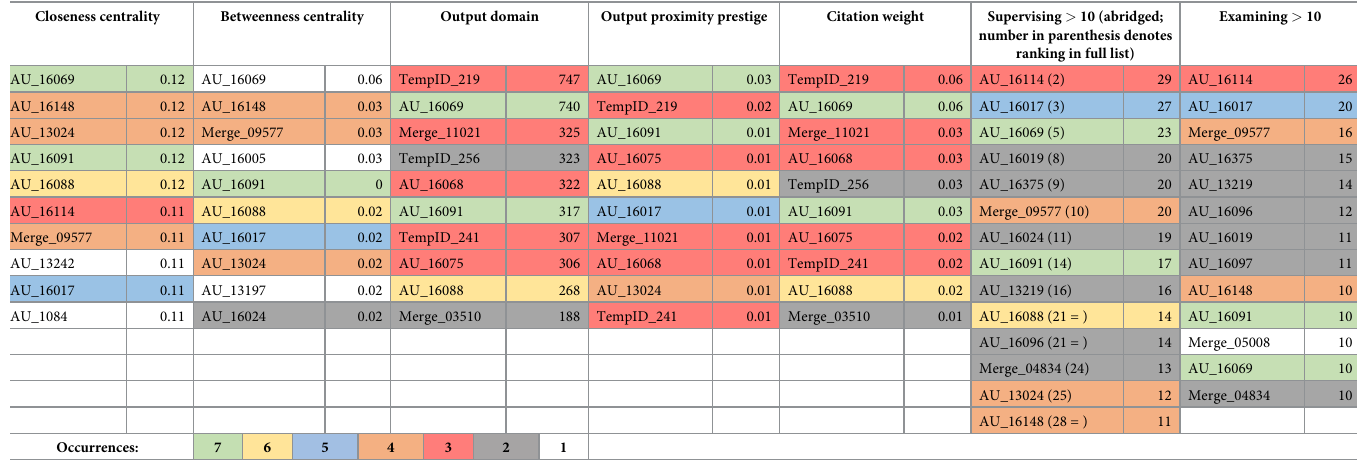
Table 4. Lists the top ten individuals for five different network measures (and those supervising/examining > 10 theses). We then removed those identified by only one measure then look at the individuals who are prominent by several different measures. Closeness Centrality and Betweenness centrality have the standard definitions. Output domain (degree) of an individual is the number of all people to whom each actor is connected. Output proximity prestige of an individual is the proportion of all other vertices in their output domain divided by the average distance from this individual to the other people in their output domain (that is, normalized output domain / average distance). The citation weight of an individual (using the Search Path Count algorithm) is the normalised sum of direct descendants.